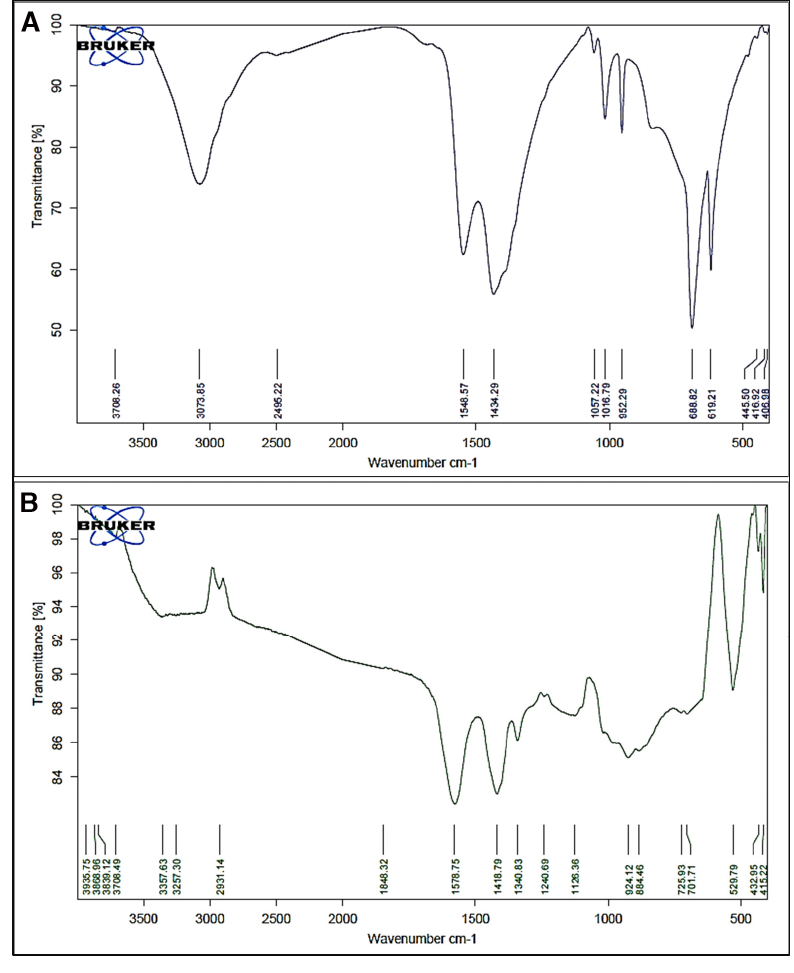
Figure 5. FTIR spectrum of ( A ) zinc acetate; ( B ) ZnO NPs.